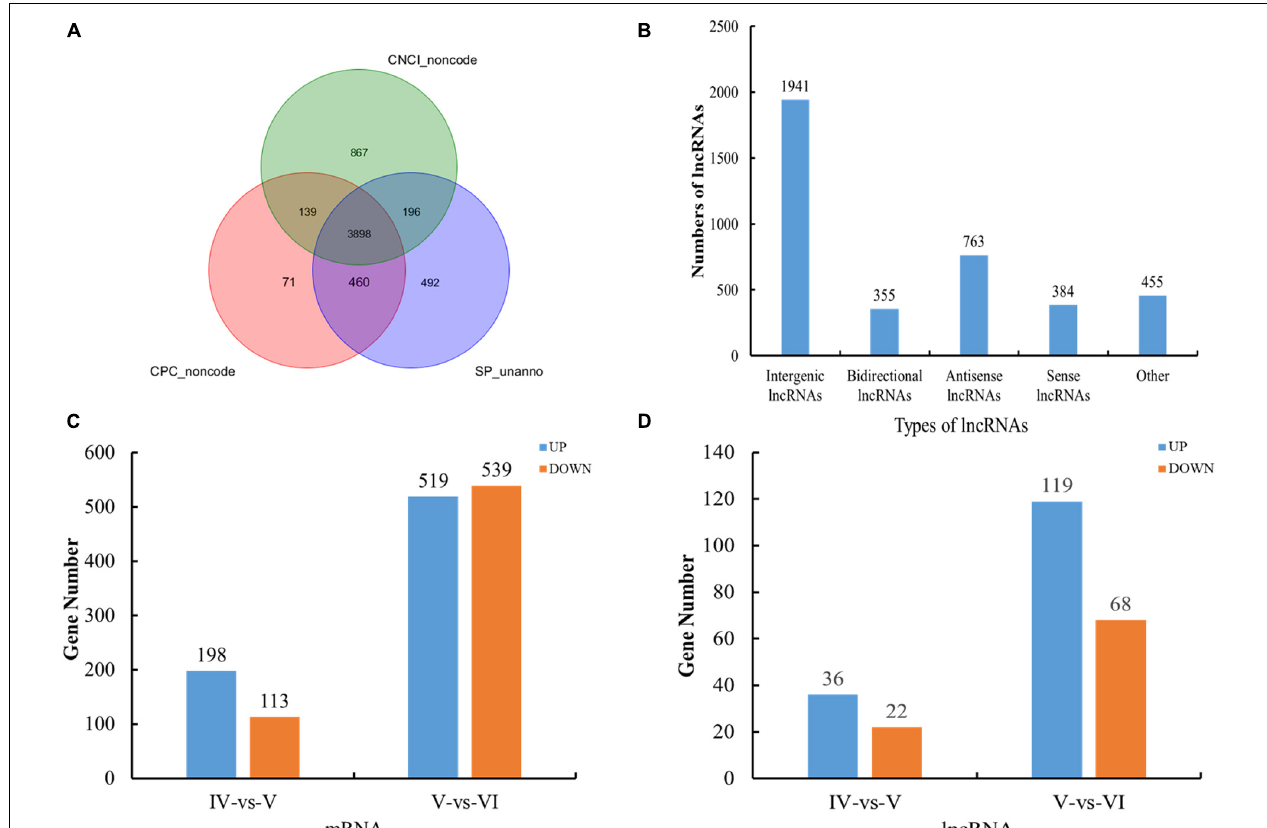
FIGURE 1 | Overview of RNA sequencing in the tongue sole ovary. (A) Venn diagrams of annotated results of CPC, CNCI, and SwissProt. (B) The categories of novel lncRNAs transcripts. (C) The histogram of differently expressed mRNA statistics. (D) The histogram of differently expressed lncRNA statistics.